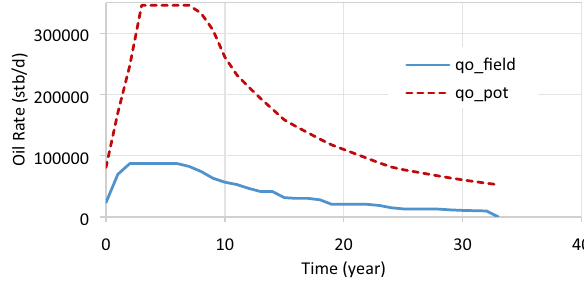
Fig. 24 Optimum oil production profile and oil production potential for strategy FPSO with MPB + WI